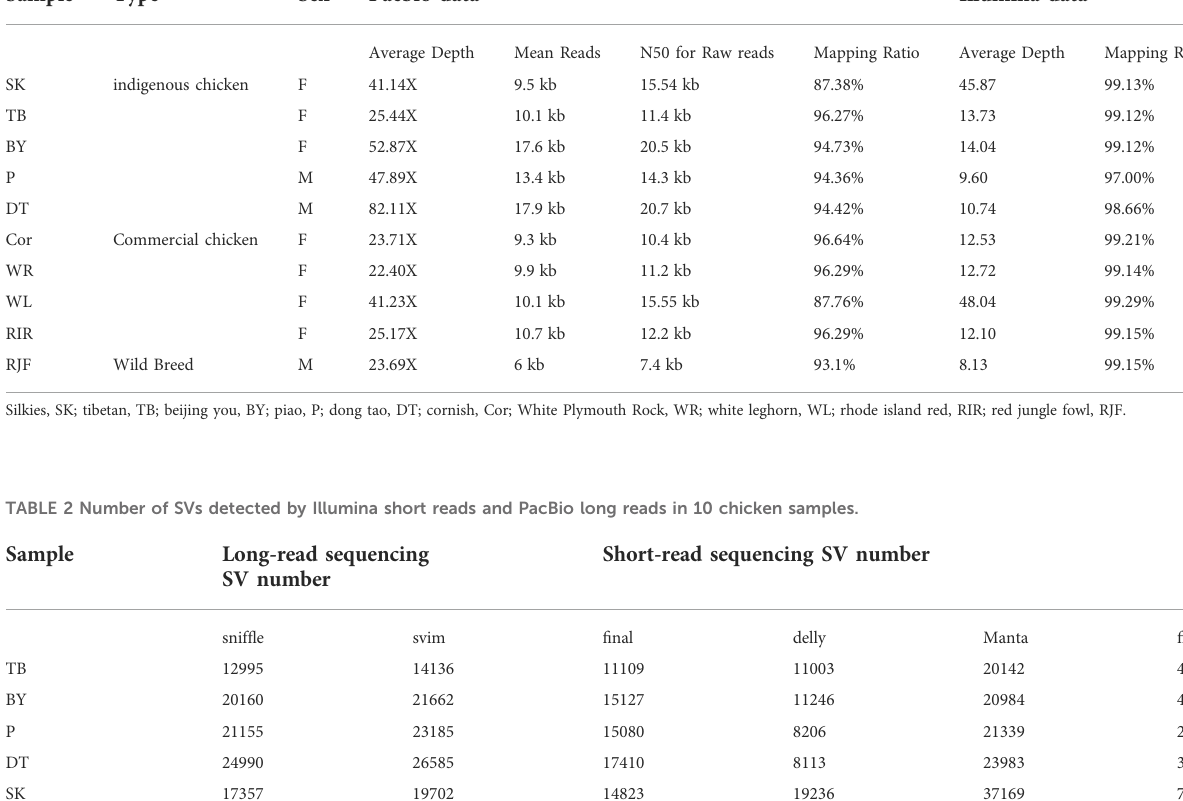
TABLE 1 Summary of sequencing information for the 10 chicken samples. Sample